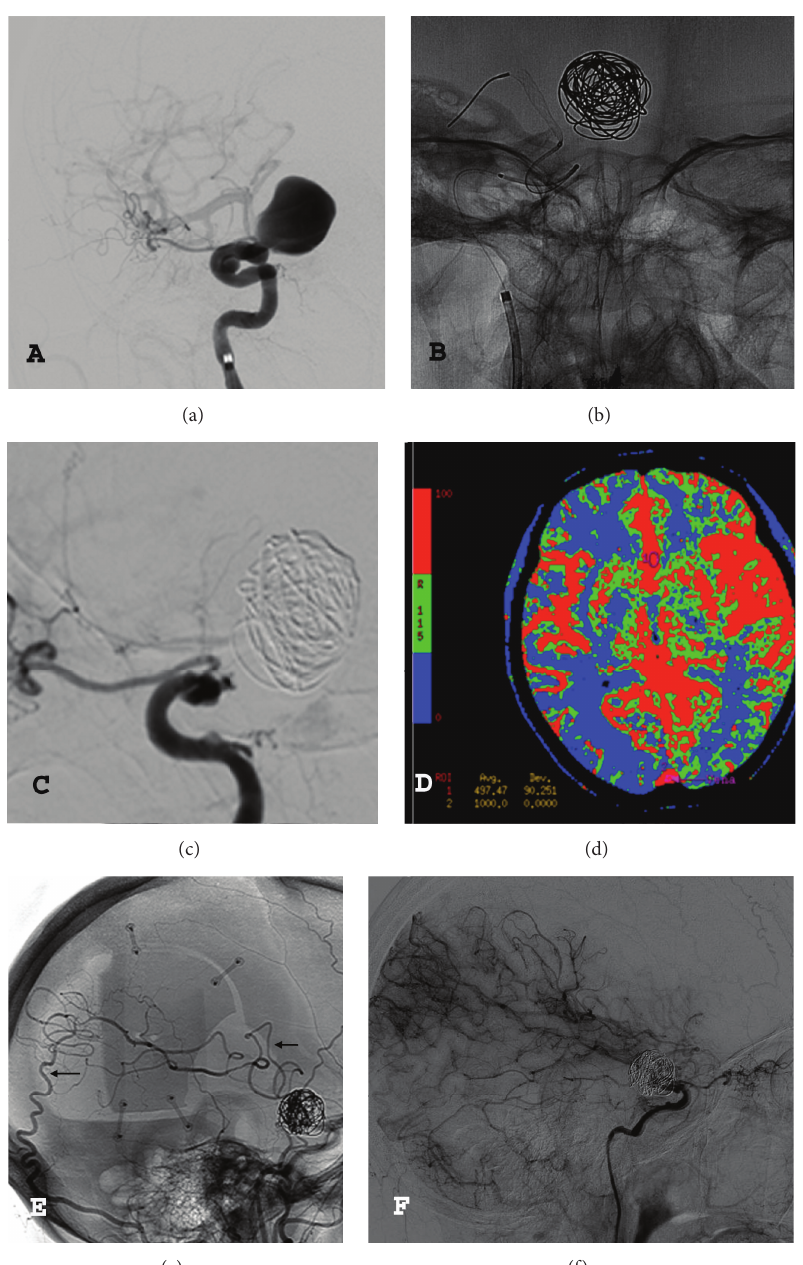
Figure 1: (a) Digital subtraction angiography showing a giant carotid-ophthalmic aneurysm on the right side. (b) Coiling and flow diverter deployment. (c) Digital subtraction angiography showing the occlusion of the internal carotid artery on the right side. (d) Perfusion-weighted CT scan: reduced cerebral blood flow on the right hemisphere. (e-f) Postoperative digital subtraction angiography (early and late phases) showing the patency of the double-barrel bypass (arrows) and the territory perfused by the